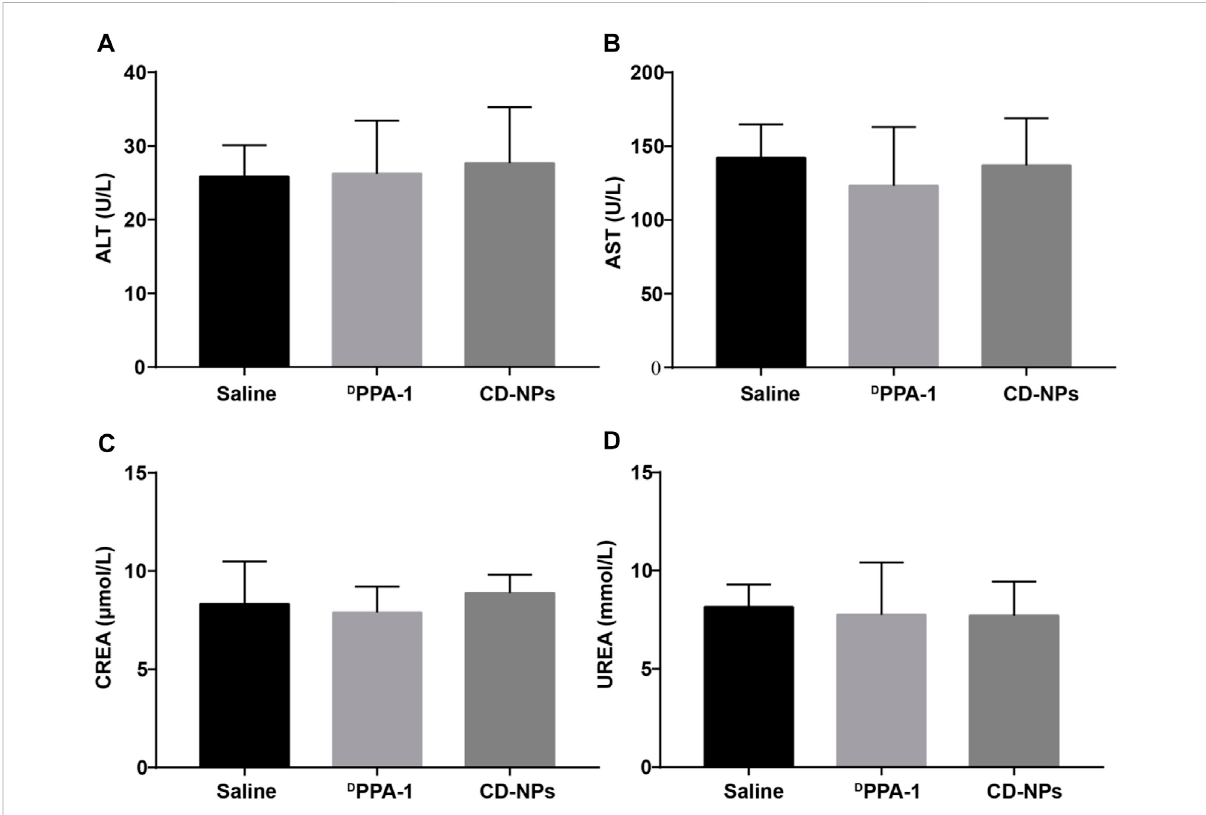
FIGURE 6 Blood biochemical level analysis of mice after treatments. Levels of (A) alanineaminotransferase (ALT) and (B) aspartateaminotransferase (AST) as well as (C) serum creatinine (CREA) and (D) urea (UREA) in blood from mice treated with different formulations. Data are shown as the mean ± SD ( n =